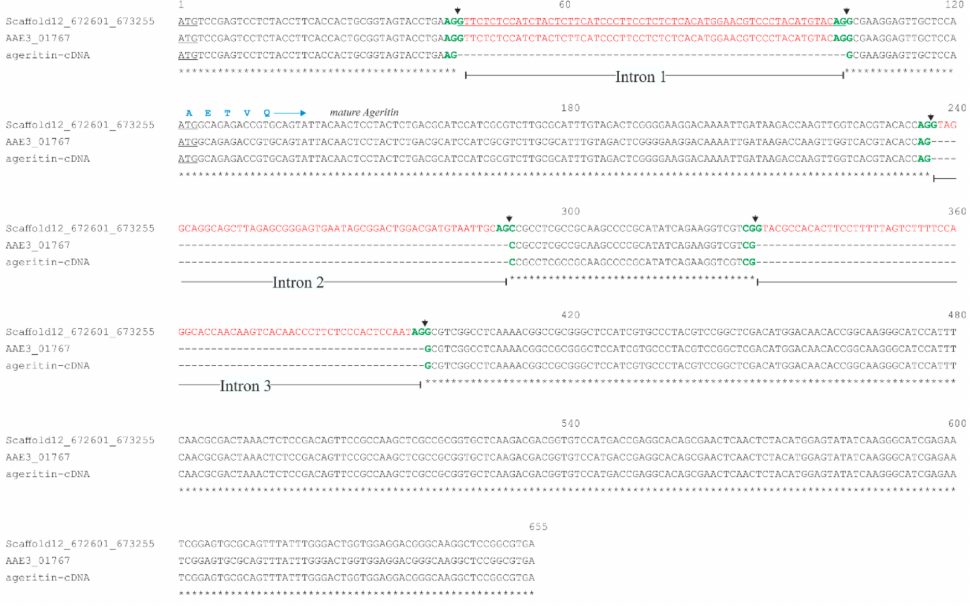
Figure 1. Sequence alignment of the ageritin -cDNA, AAE3_01767 and sca ff old 12 genomic region 672601-673490. The ATG codon is underlined in black; the exons are reported in black, introns in red (new intron red and underlined, see main text), the splice junctions in green. The arrows indicate the splicing site. In blue the first amino acid residues of mature Ageritin. Fully conserved bases are indicated by